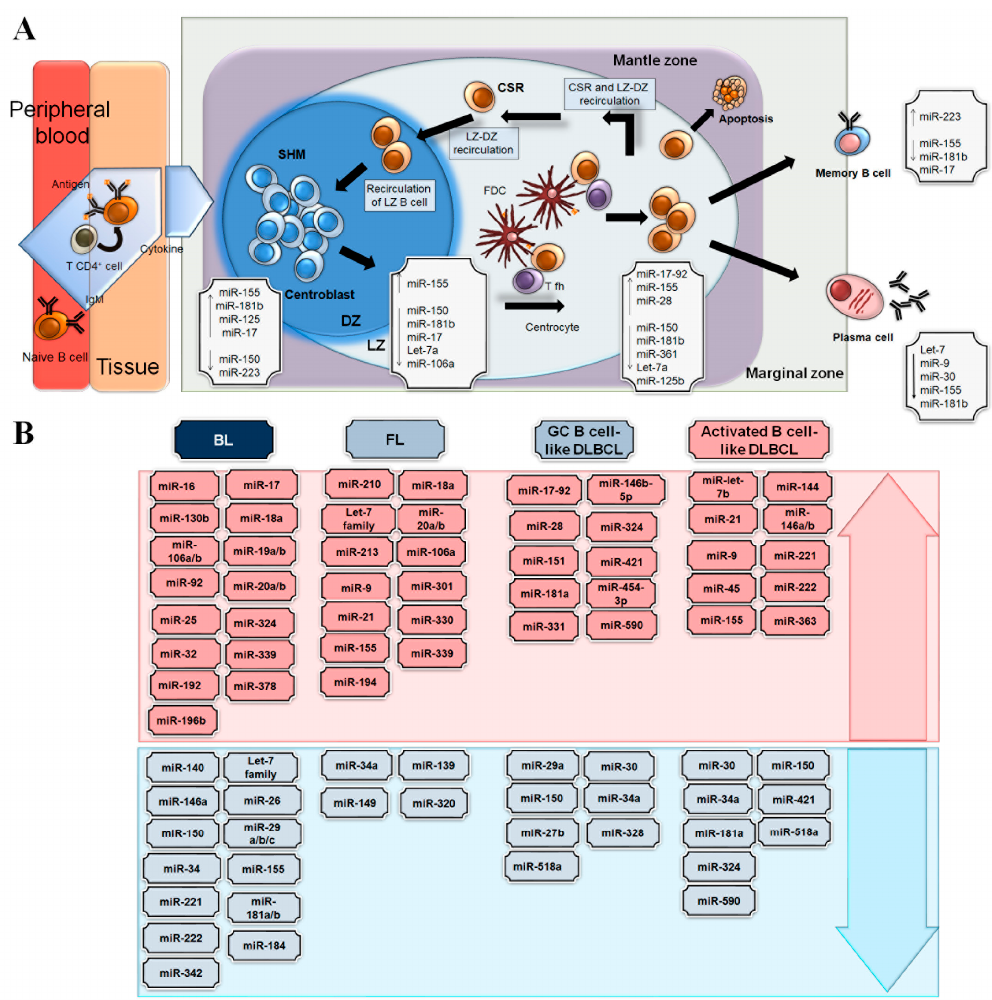
Figure 2. Major miRNAs playing a role in B-cell functions and lymphomagenesis. ( A ) Graphic representation of di ff erent miRNAs involved in the B-cell functions in the germinal centre. The insides of the boxes show the miRNAs reported to have relevant roles in the di ff erent areas of the germinal centre. ( B ) The miRNAs that are up- (in red) and downregulated (in blue) are described for di ff erent B-cell lymphomas: Burkitt lymphoma (BL), follicular lymphoma (FL), germinal centre B cell-like (GCB)-di ff use large B cell lymphoma (DLBL), and activated B cell-like (ABC)-DLBCL.